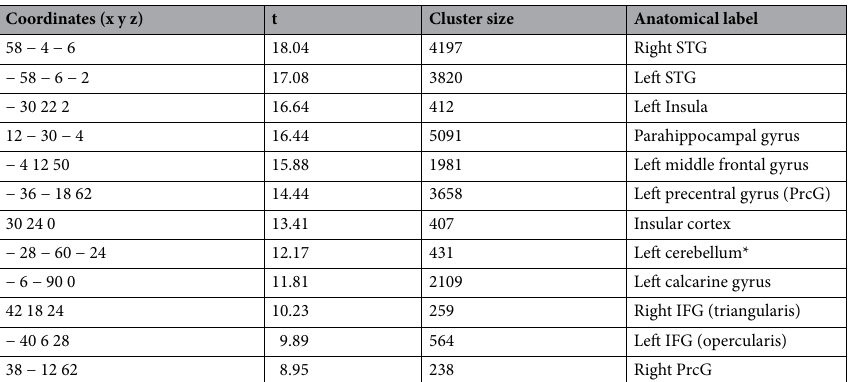
Table 4. Random effects analysis for the identification task (contrast all voices > baseline) at p < 0.05 FWE- corrected, extent threshold = 100 mm 3 . The 1st column of the table reports the MNI coordinates of local maxima (peaks separated by more than 8 mm); the 2nd column contains t-values estimating the contrast of interest (height threshold t (1, 38) = 6.15, p < 0.05 FWE corrected); the 3rd column reports relative cluster size in voxels; the 4th column contains the anatomical locations of the corresponding cluster. *Cerebellum is not shown in the render.